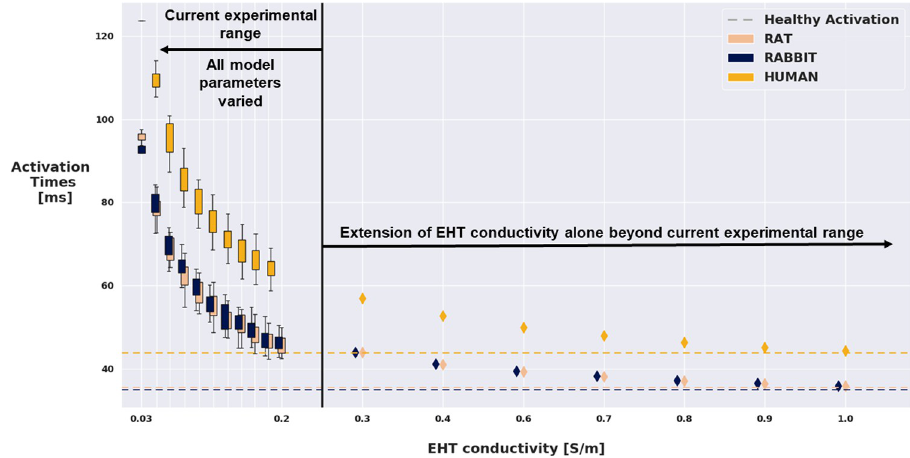
Fig 7. Model output (REAT) VS EHT conductivity for the rat, rabbit and human model, in the fixed setup. Boxplots represent the distribution of REATs among the 500 LH simulations that had the EHT conductivity restricted to current experimental ranges. Diamonds represent REATs obtained by fixing all the other parameters and increasing EHT conductivity by multiplying the upper bound of the range used in the LH by 1.5, 2, 2.5, 3, 3.5, 4 and 4.5 folds. Dashed line indicates the healthy REAT estimated by our